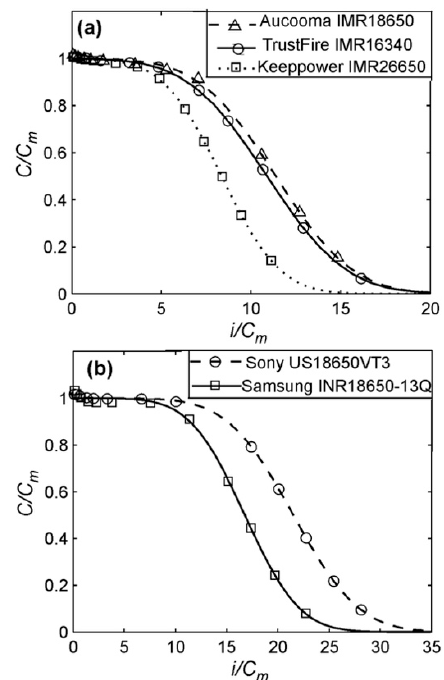
Figure 2. Comparison between experimental data for lithium-ion cells of different types and Equation (9): ( a ) cell with cathode LiMn 2 O 4 (IMR); and ( b ) cell with cathode LiNiMnCoO 2 (INR). For each cell, the value of C m was taken from Table 2. △ , ○ , (cid:0) , experimental values. Table 2. Optimal parameters of generalized Peukert Equations (7)–(9) for lithium-ion cells. Manufacturer and